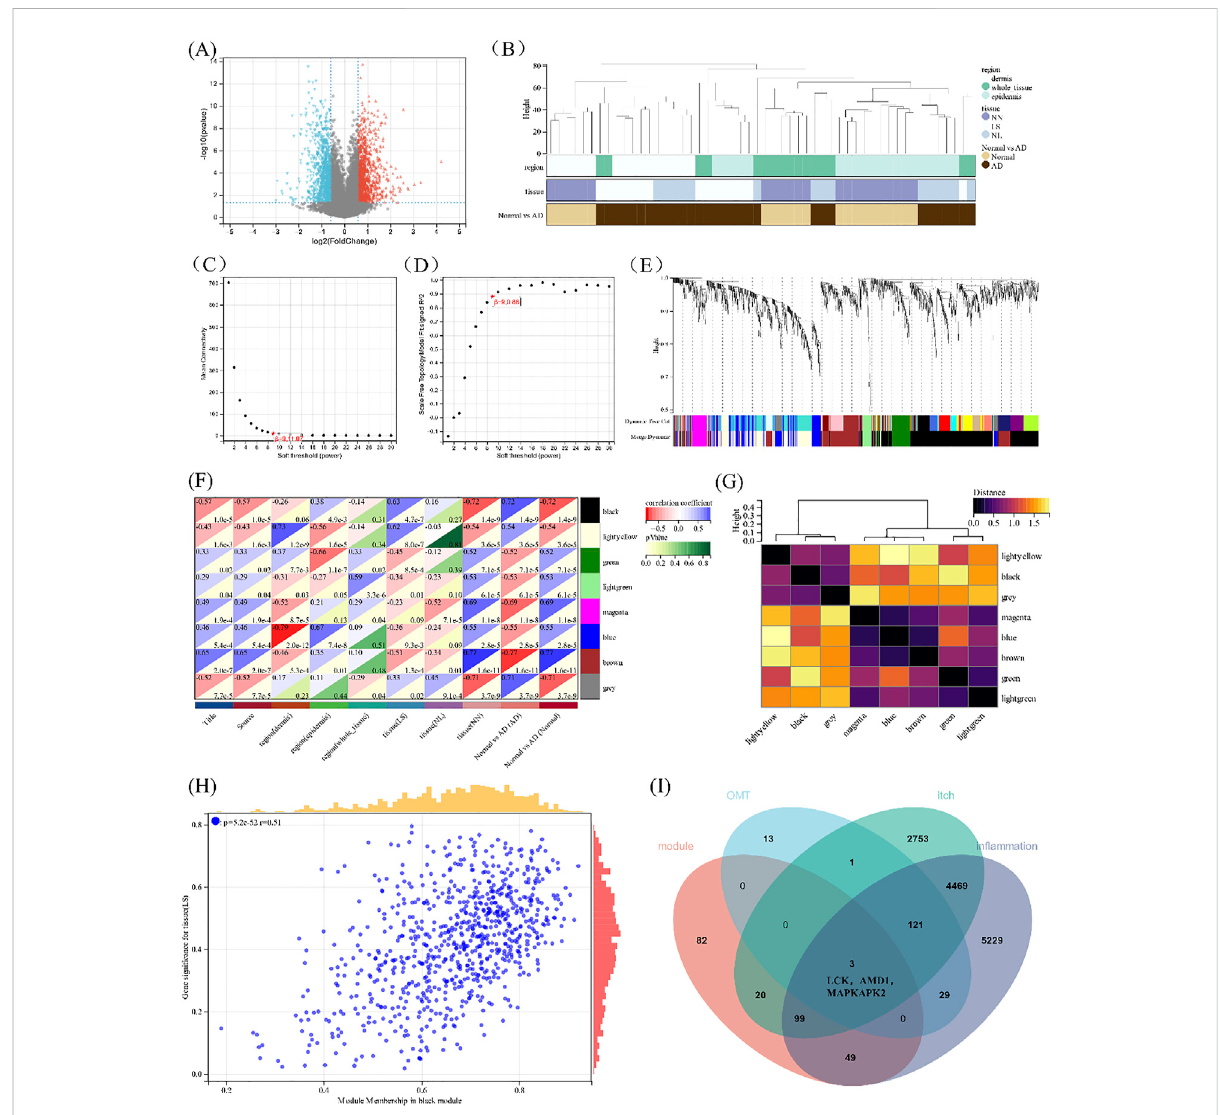
FIGURE 5 Construction of WGCNA. (A) The volcano plot of differentially expressed genes between atopic dermatitis and normal samples. (B) Clustering dendrogram of samples. (C,D) Analysis of the scale-free fi tting indices for various soft-thresholding powers ( β ) and mean connectivity analysis of various soft-thresholding powers. (E) Clustering dendrogram of genes based on the measurement of dissimilarity (1-TOM). (F) The heat map of correlation between the module eigengenes and atopic dermatitis. (G) Heat map of the module eigengenes. (H) Scatter plot of module tissue (LS) in the black modulo. (I) Venn diagram of the black and yellow module eigengenes, the target of 0MT, itching, and in fl